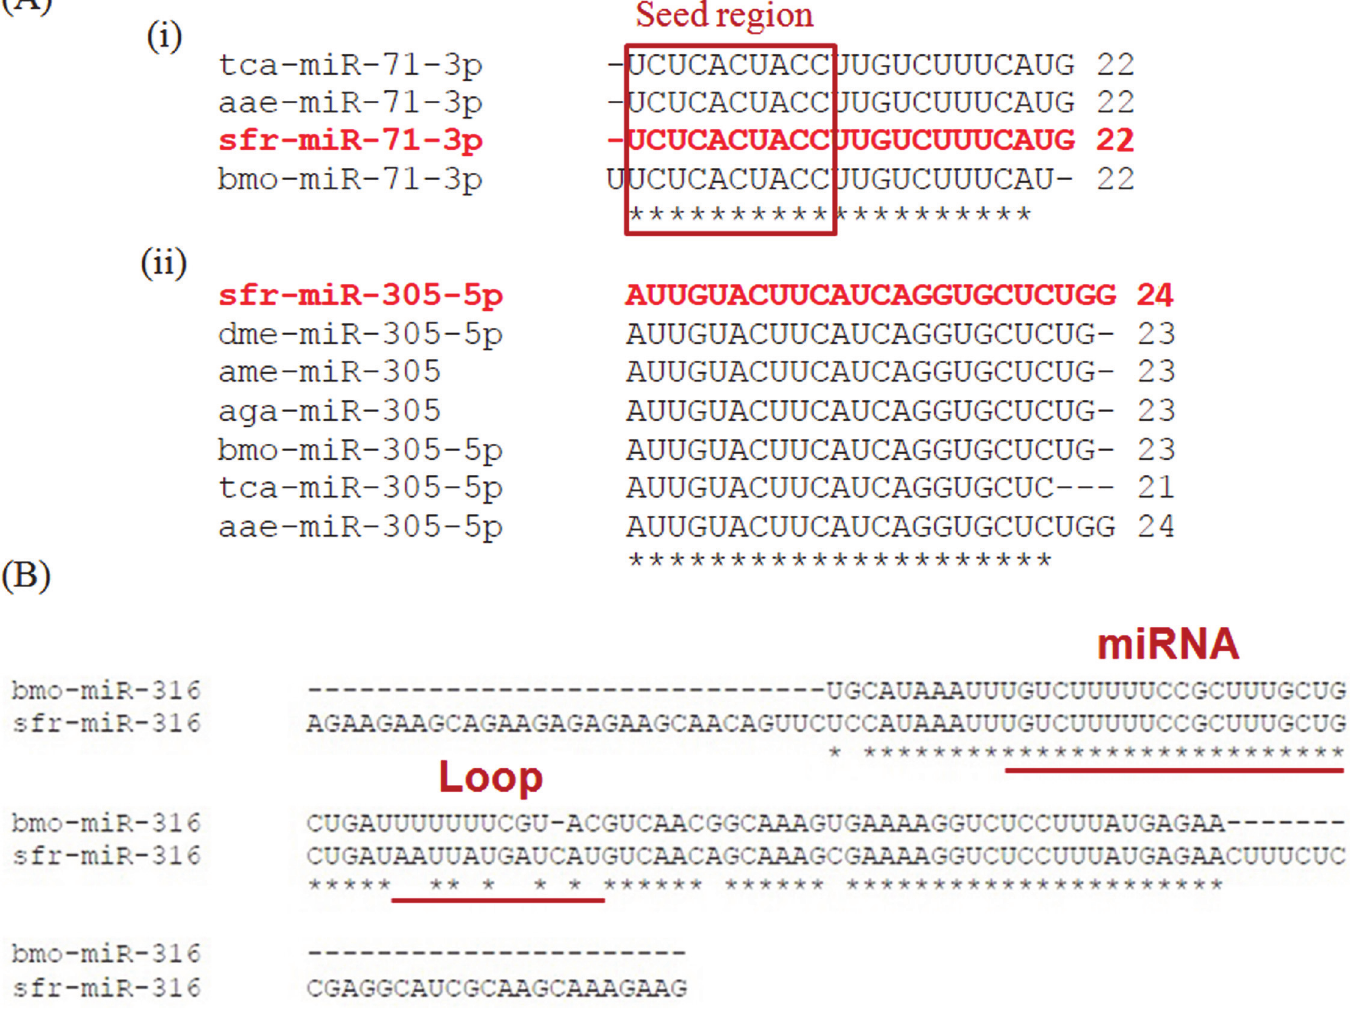
Fig 2. Homology analysis of Spodoptera miRNAs. (A) (i) Identity in the seed region of the Spodoptera miRNA with respect to its counterpart from other insects. (ii) Sequence conservation of the Sf miRNA, including the seed region over a wide range of insect species. (B) Similarity between the precursor sequences of Sf miRNA with its counterpart from B. mori . The nucleotide differences are only outside the mature region but in the stem loop